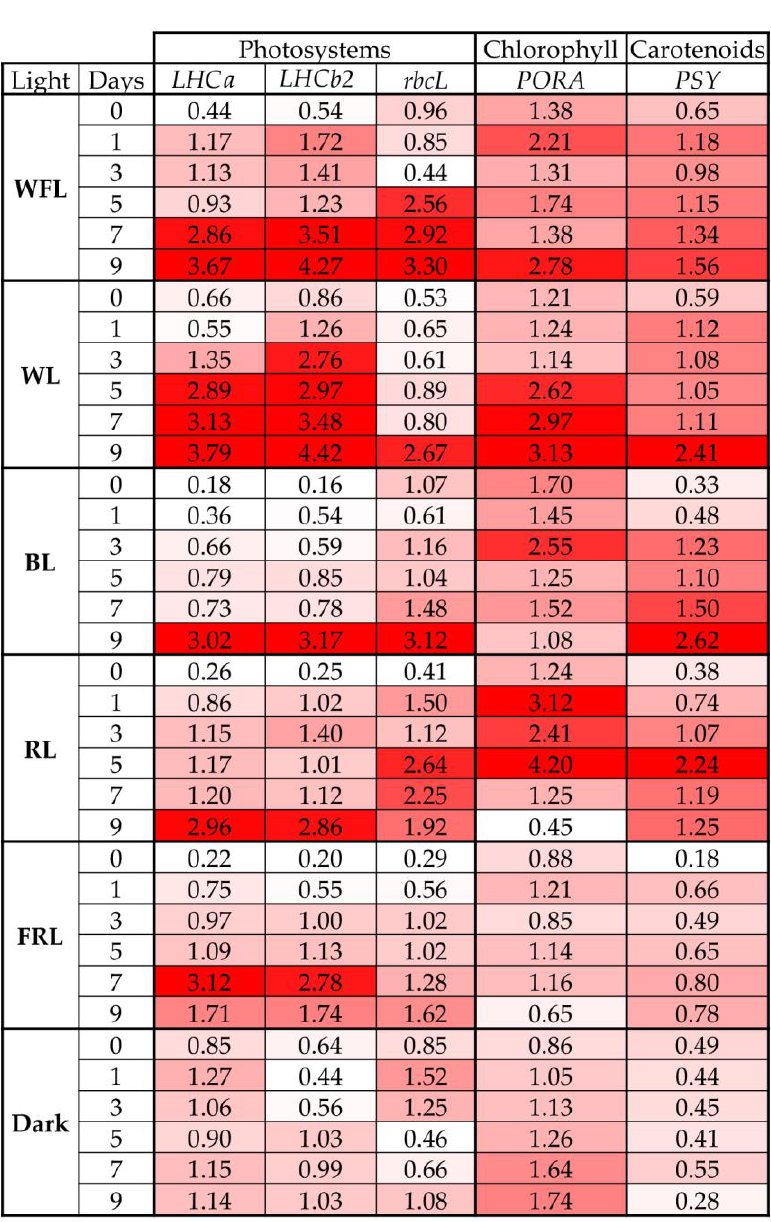
Figure 5. Transcript levels of main genes of light harvesting complex of Chl- a / b -binding proteins ( LHCa , LHCb2 ), and large subunit of RubisCo ( rbcL ), chlorophyll biosynthesis gene protochloro- phyllide oxidoreductase ( PORA ), main gene of carotenoids biosynthesis phytoene synthase ( PSY ) in Scots pine plantlets under different light quality and dark on the 0, 1, 3, 5, 7, 9 days of experiment. The color scale rules: increase in expression by at least two times (dark red light) relative to the average value of the expression of the specified gene in column.